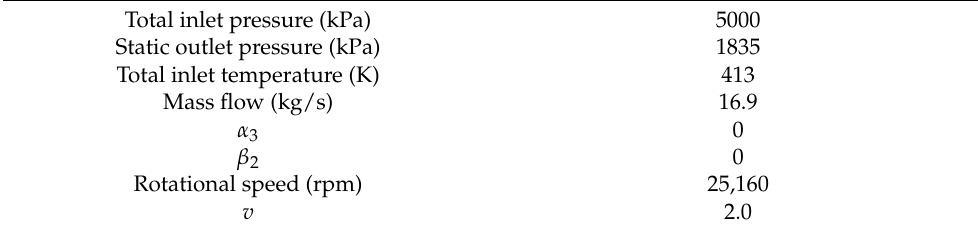
Table 4. Input parameters used for the optimization of the Do-Yeop [48] case.